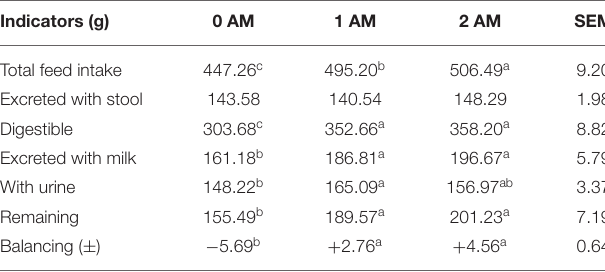
TABLE 5 | Nitrogen balance in the lactating cows.